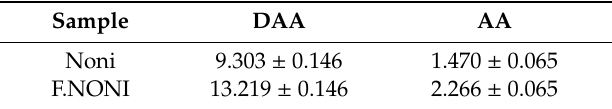
Figure 1. Representative HPLC-UV chromatogram of noni and F.NONI. ( A ) Standard; ( B ) Noni extract; ( C ) F.NONI extract. The arrows represent deacetylasperulosidic acid (DAA) and asperulosidic acid (AA). (Standard DDA Rt: 18.78 ± 0.06 min; noni and F.NONI each 18.78 ± 0.08 and 18.79 ± 0.07 min. Standard AA Rt: 27.31 ± 0.05 min; noni and F.NONI each 27.32 ± 0.06 and 27.32 ± 0.07 min) AU: Absorption unit. Table 2. Content of deacetylasperulosidic acid (DAA) and asperulosidic acid (AA) in the Noni and F.NONI extract (mg / g of concentrate